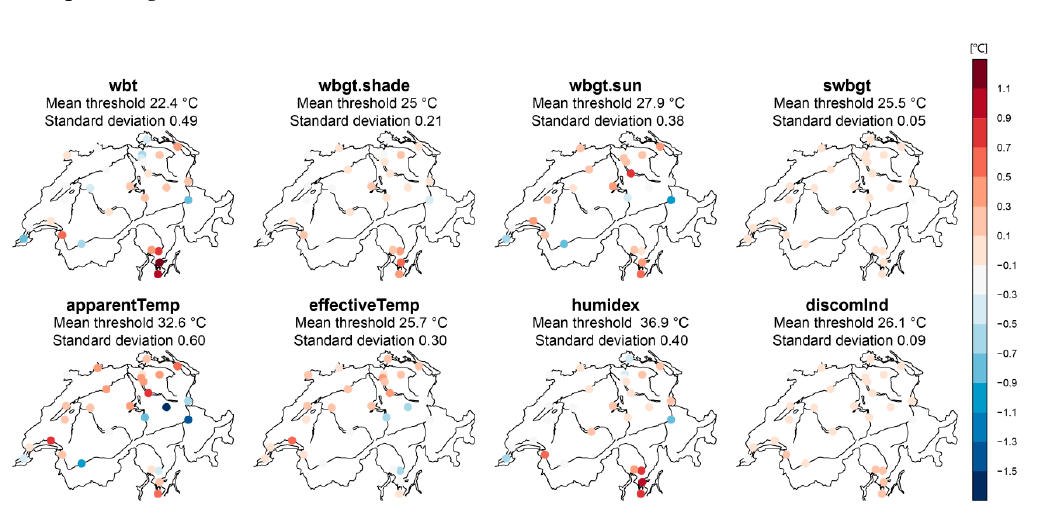
Figure 5. Spatial anomalies of site-specific thresholds (color-coded) and spatial averages and standard deviations of the site-specific thresholds (on top of each map) for the considered indices wet bulb temperature ( wbt ) , wet bulb globe temperature in the shade ( wbgt.shade ), wet bulb globe temperature in the sun ( wgbt.sun ), simplified wet bulb globe temperature ( swbgt ), apparent temperature ( apparentTemp ); effective temperature ( effectiveTemp ), humidity index ( humidex ) and discomfort index ( discomInd ). Anomalies are computed wrt. the respective spatially averaged site-specific threshold. Blue colors apply to negative threshold anomalies, red colors to positive threshold anomalies.